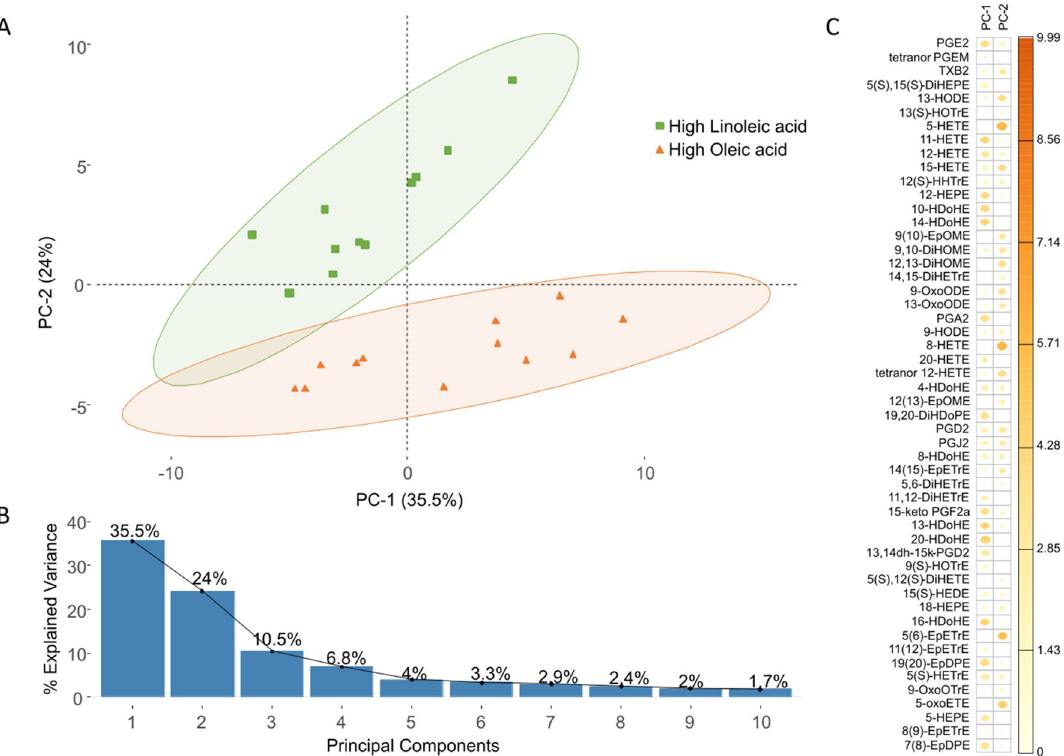
Figure 1. Dietary fatty acid composition determines circulating plasma fatty acyl lipidome content. ( A ) Principal component analysis (PCA) of rat plasma LMs after exposure to a diet rich in LA (green squares, n = 11) or OA (orange triangles, n = 12). Distribution of plasma samples in the space of principle component 1 (PC-1) and principal component 2 (PC-2), which captured 35.5% and 24.0% of the total variance, respectively. Plasma samples were strongly separated along PC-2 based on diet. ( B ) Fraction of total variance explained by PC-1 through PC-10. ( C ) Factor map of individual LMs contributing to PC-1 and PC-2. LMs with larger/darker dots contribute more to the corresponding principal